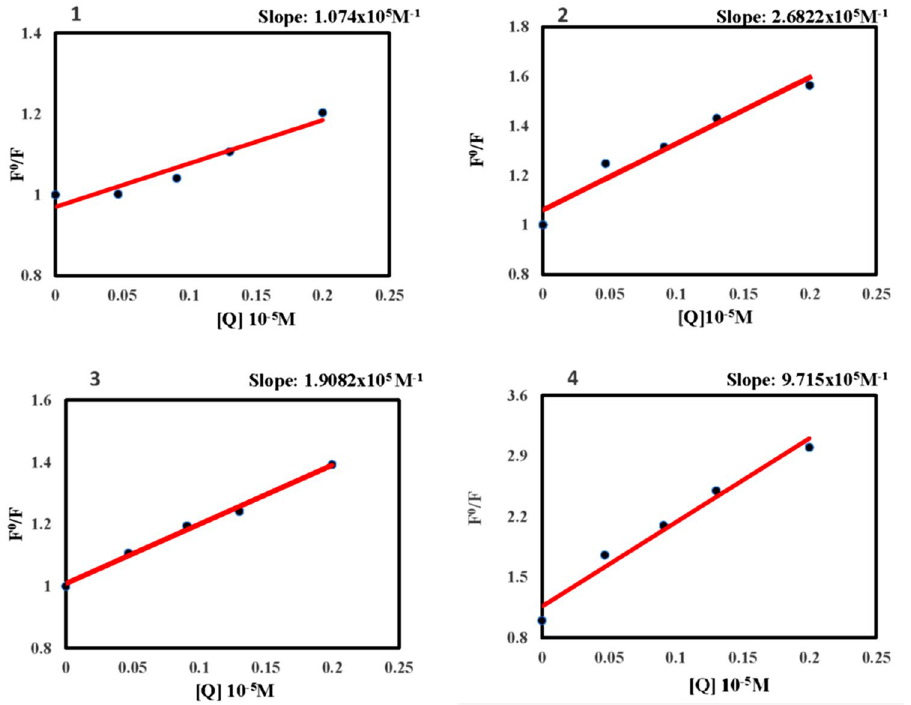
Figure 5. Stern–Volmer plots of compounds 1 –